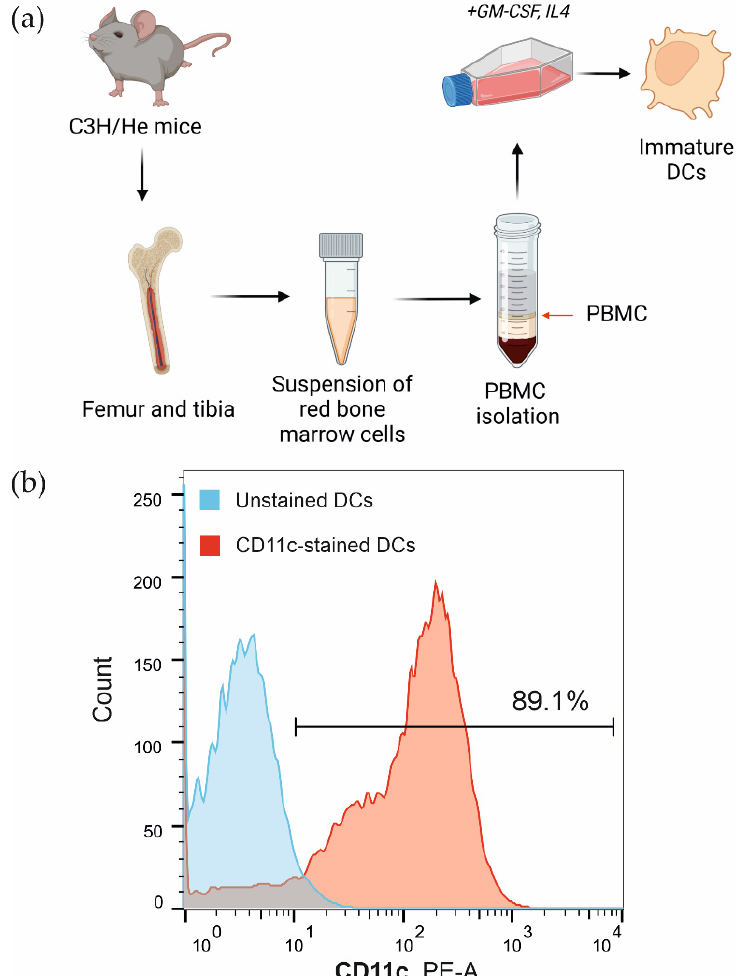
Figure 2. Immunophenotyping of PBMC isolated from the bone marrow of the femurs and tibias of C3H/He mice. ( a ) Scheme of the dendritic cell (DCs) isolation and cultivation. ( b ) Flow cytometry analysis of cells stained with fluorescently labeled anti-CD11c antibodies. A representative example of the analysis.